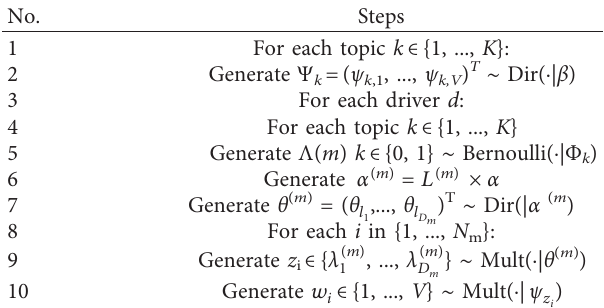
Table 3: Generative process for the labeled LDA model. No.